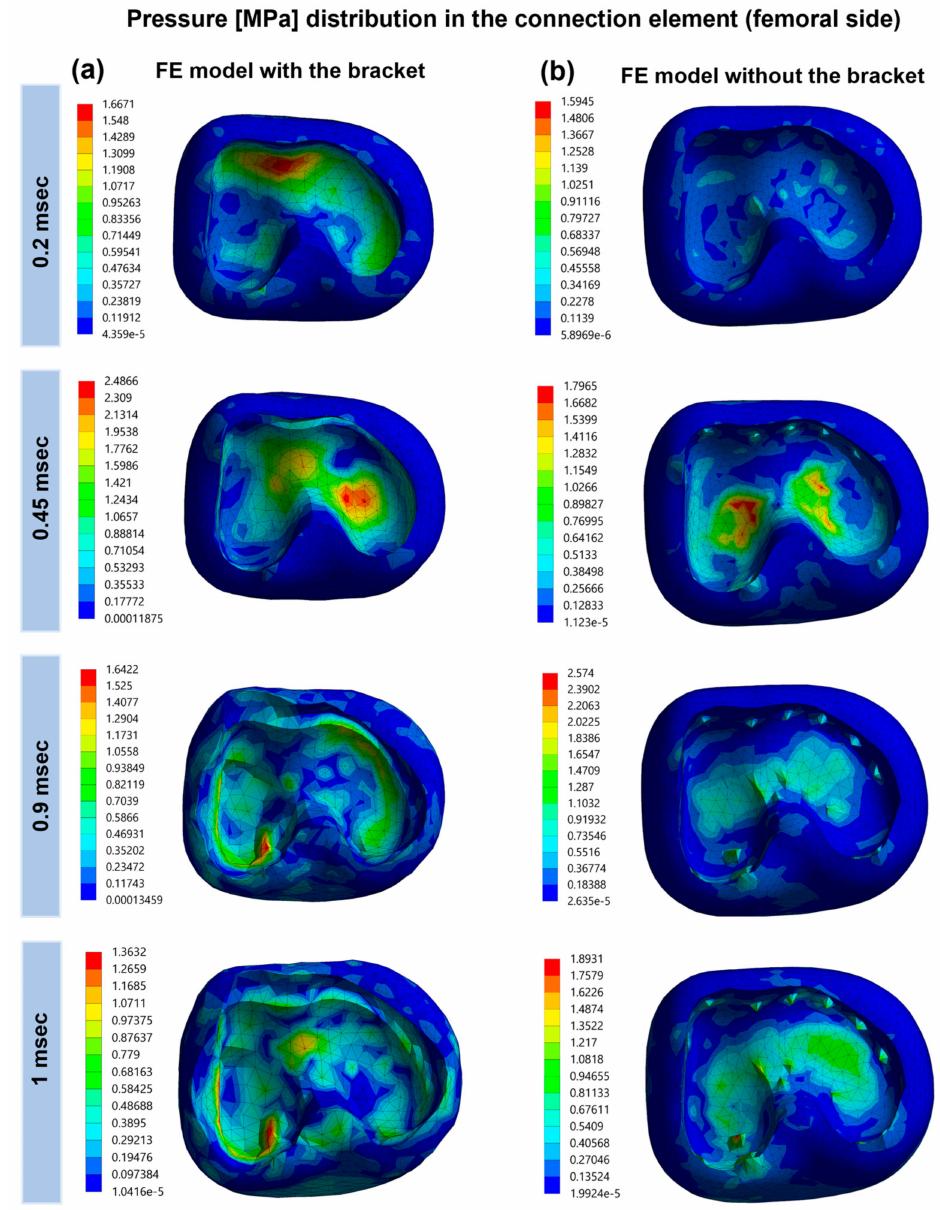
Figure 10. Pressure distribution in the connection component (femoral side) of the limb for the FE model ( a ) with and ( b ) without